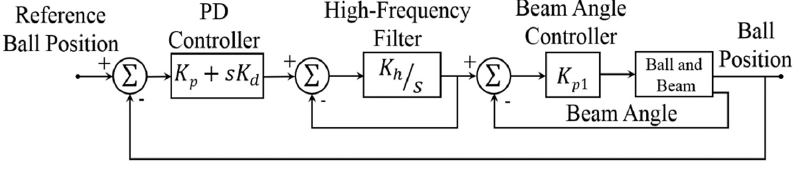
Figure 11. PD design for the ball and beam apparatus.